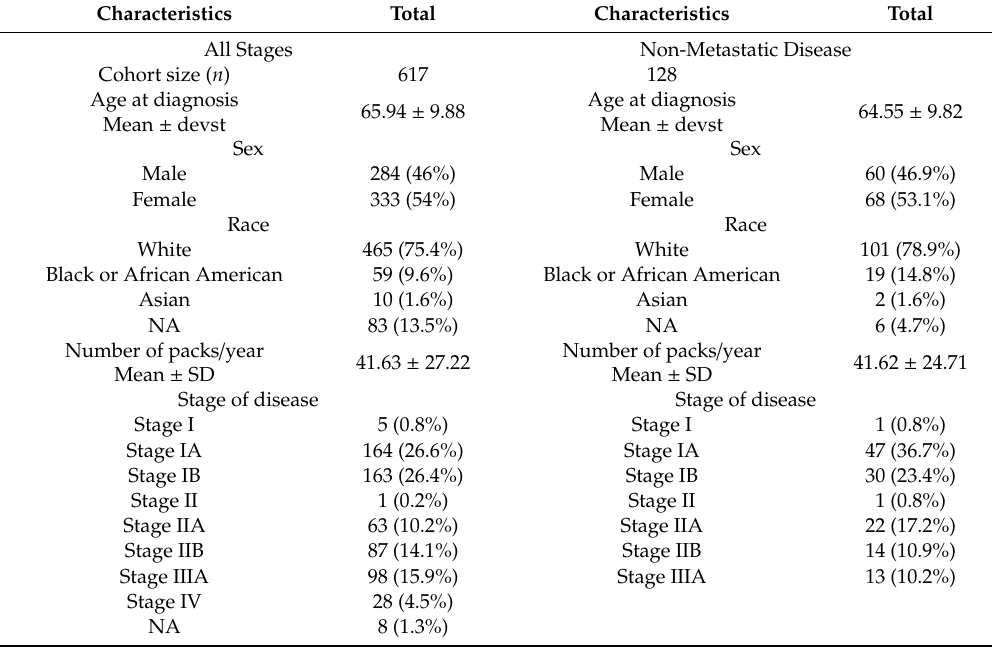
Table 2. Clinical-pathological data of lung adenocarcinoma (LUAD) from The Cancer Genome Atlas (TCGA) dataset.